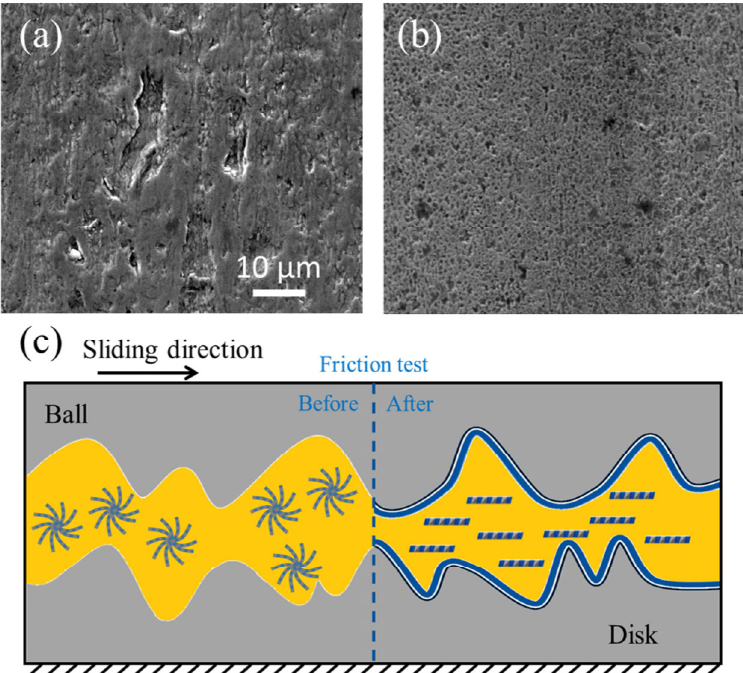
Fig. 8 High magnification SEM images of wear track lubricated by (a) base grease and (b) 1 wt% flower-like MgAl–LDH in base grease. (c) Schematic illustration of the proposed lubrication model with flower-like LDH additives in base